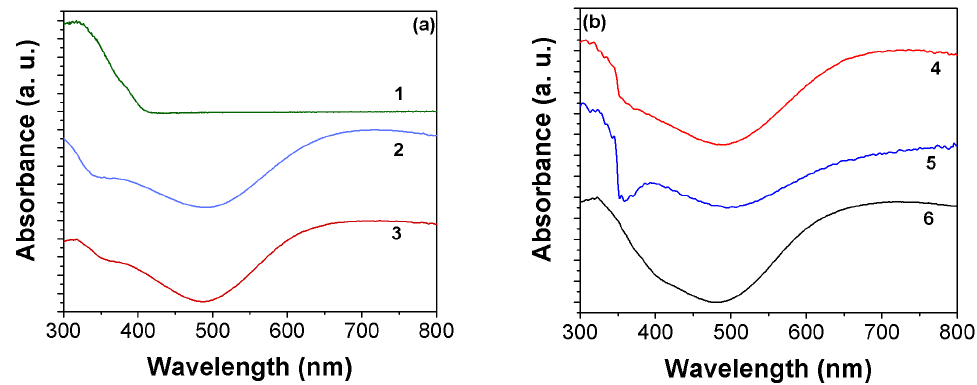
Figure 4. UV-Vis DRS spectra of ( a ) P25 (1), syn-HKUST-1 (2), com-HKUST-1 (3), and ( b ) TiO 2 /HKUST-1 composites: 50TiO 2 P25/com-HKUST-1 (4), 50TiO 2 ST/com-HKUST-1 (5), and 50TiO 2 P25/syn-HKUST-1 (6).